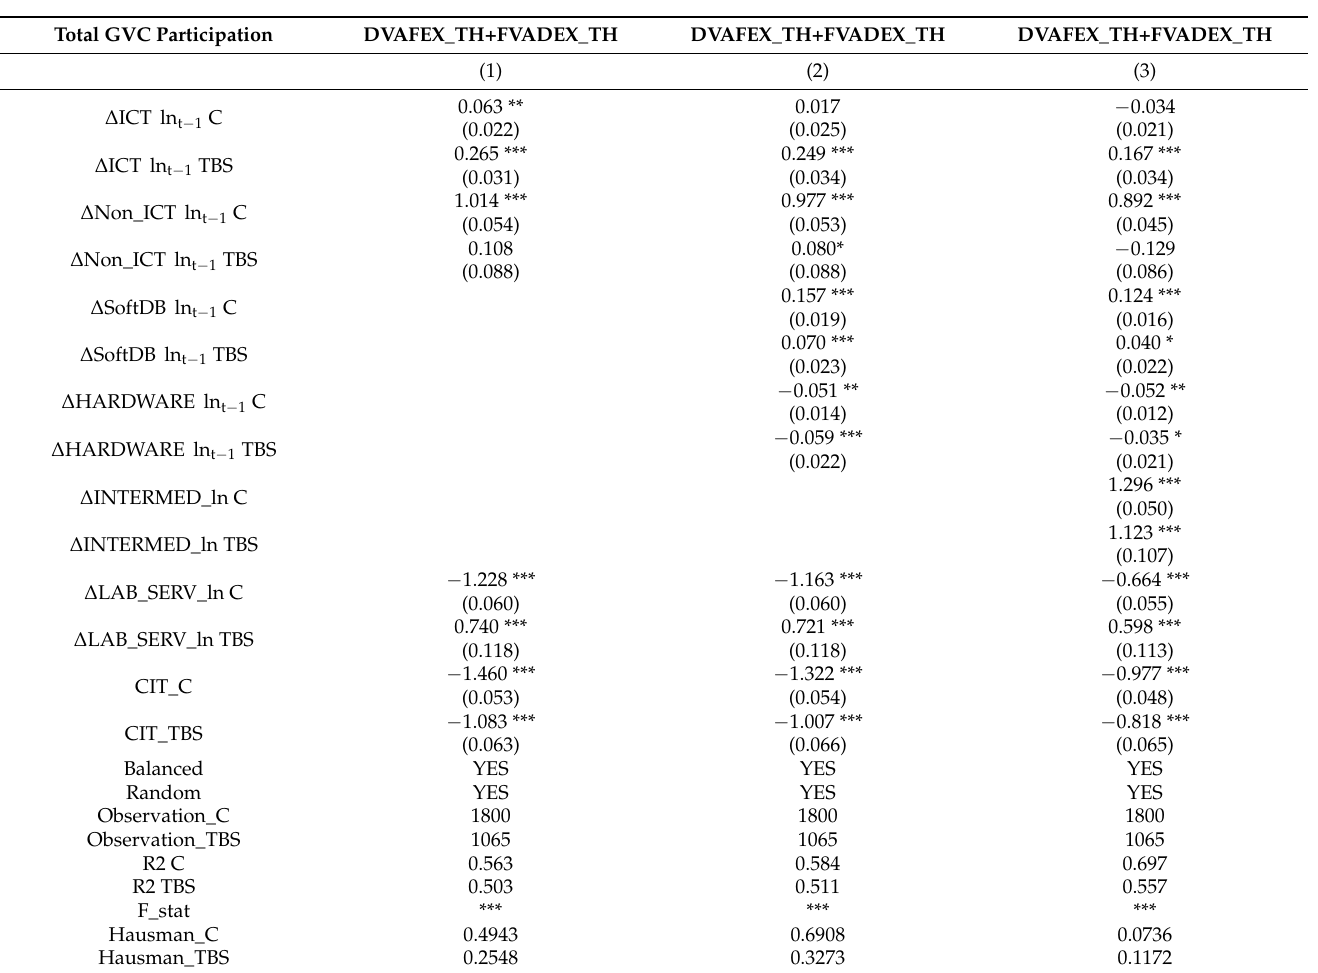
Table 6. Random effect panel regression results of the impact of ICT assets on participation in the GVC in the manufacturing sector (C) and total business sectors (TBS). The level of statistical significance